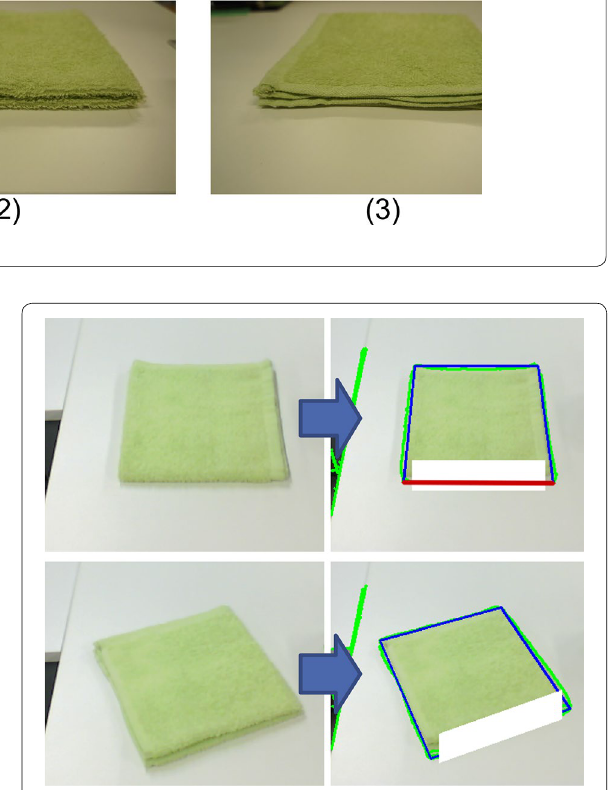
Fig. 9 Results of the thickest hem detection in a case where one hem is visible on the near side